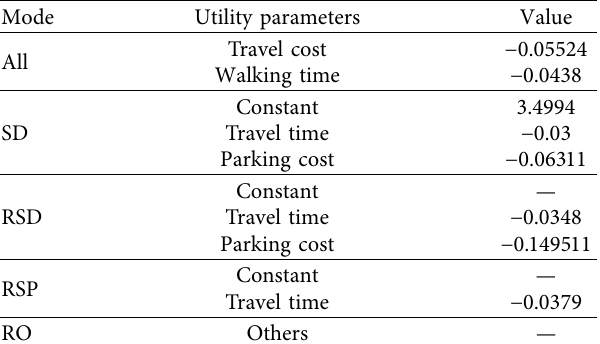
Table 5: Utility